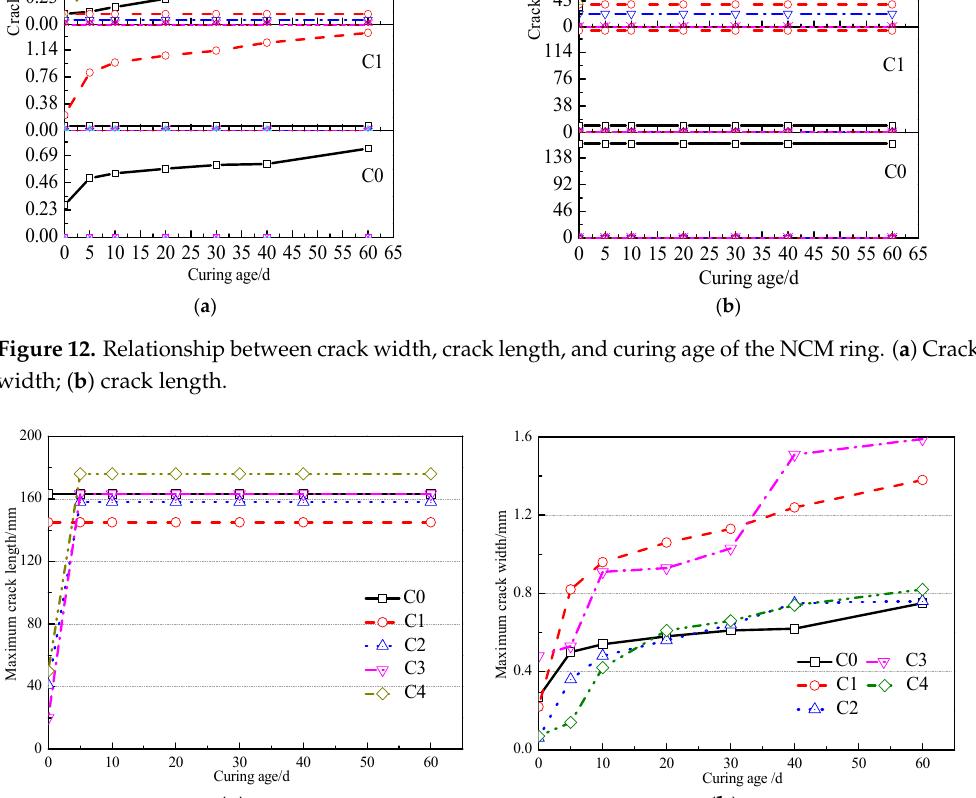
Figure 12. Relationship between crack width, crack length, and curing age of the NCM ring. ( a ) Crack width; ( b ) crack length.